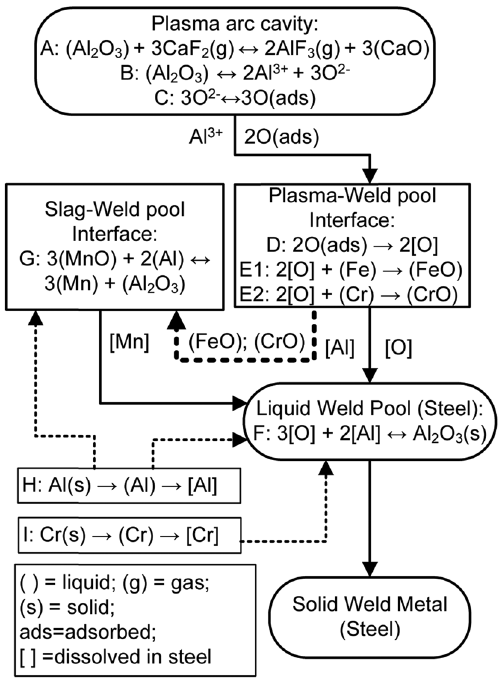
Figure 6: SAW reaction fl ow diagram with Al and Cr powder